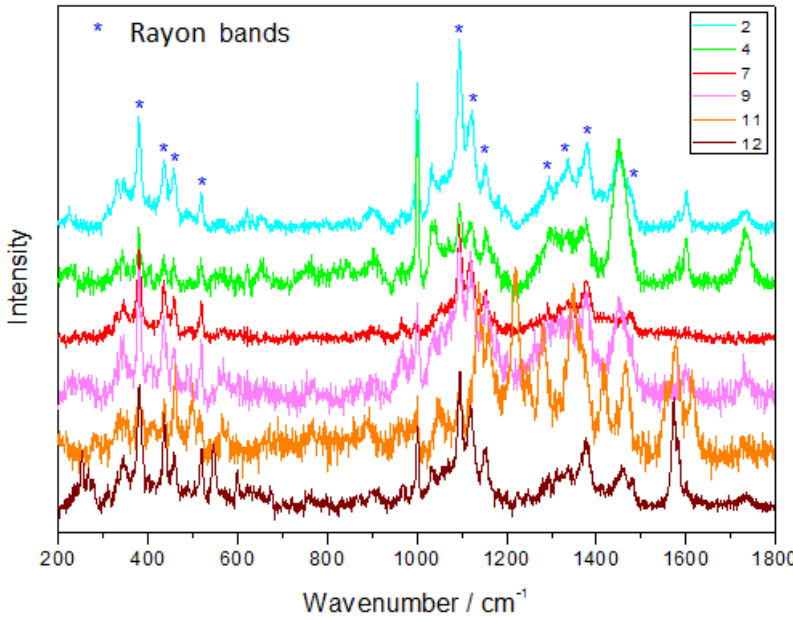
Figure 7. The Raman spectrum of semi-synthetic cellulosic rayon, acquired using the Raman spec- troscopy. The samples from the Barents Sea are numbered from 2 to 4, and those from the tundra lakes are numbered from 7 to 12.